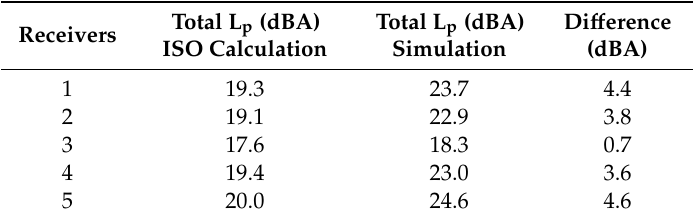
Table A3. Comparison between total SPL (dBA) numerical and ISO results at the Cape Busto location